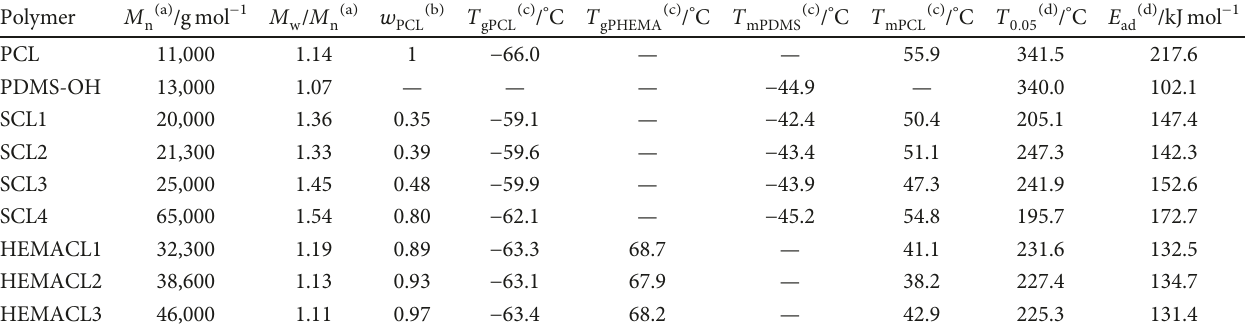
Table 1: Chemical and thermal characterization of synthesized linear PCL and PDMS-OH homopolymers, and PCL-based copolymers. Polymer